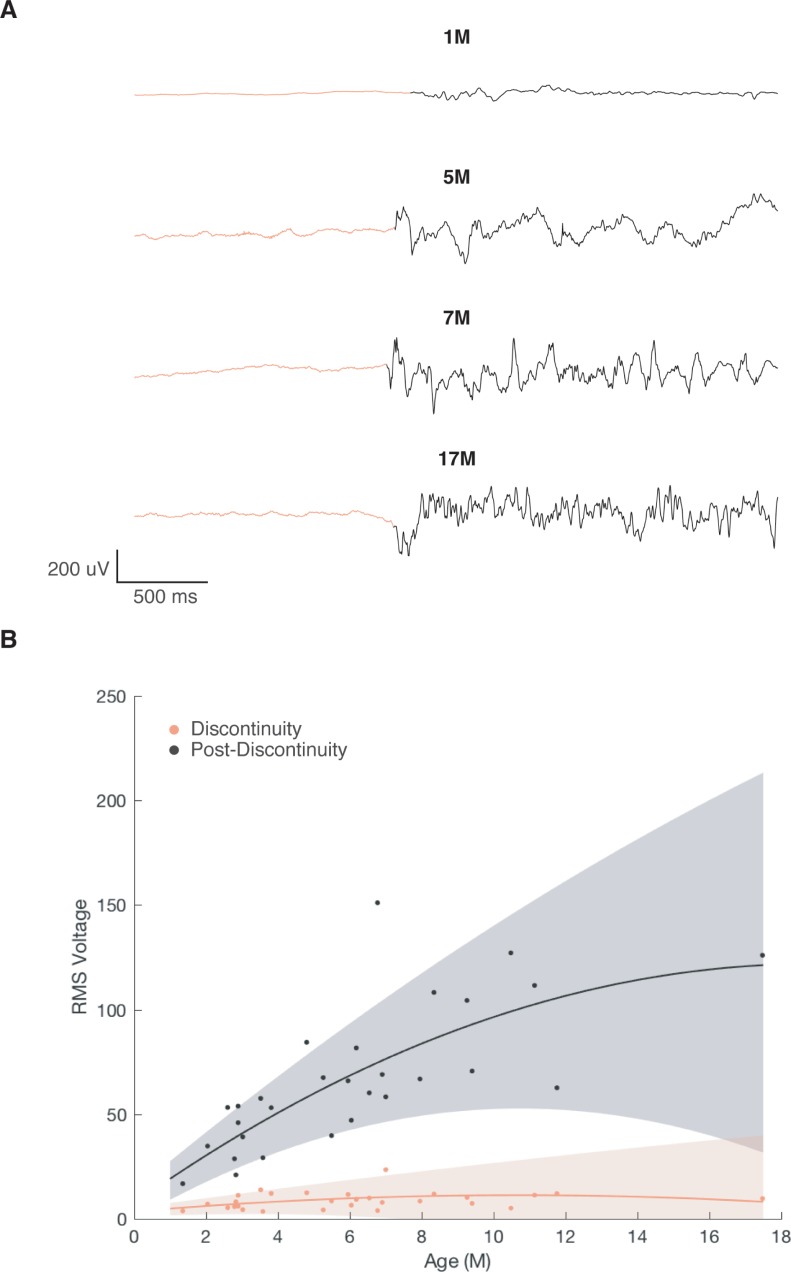
Amplitude of discontinuous activity increases with age.(A) Representative raw traces of burst-like activity following suppression in children aged 1-, 5-, 7-, and 17-months-old. (B) Root mean squared amplitude of 2s of burst-like activity following suppression increases with age (n = 29).